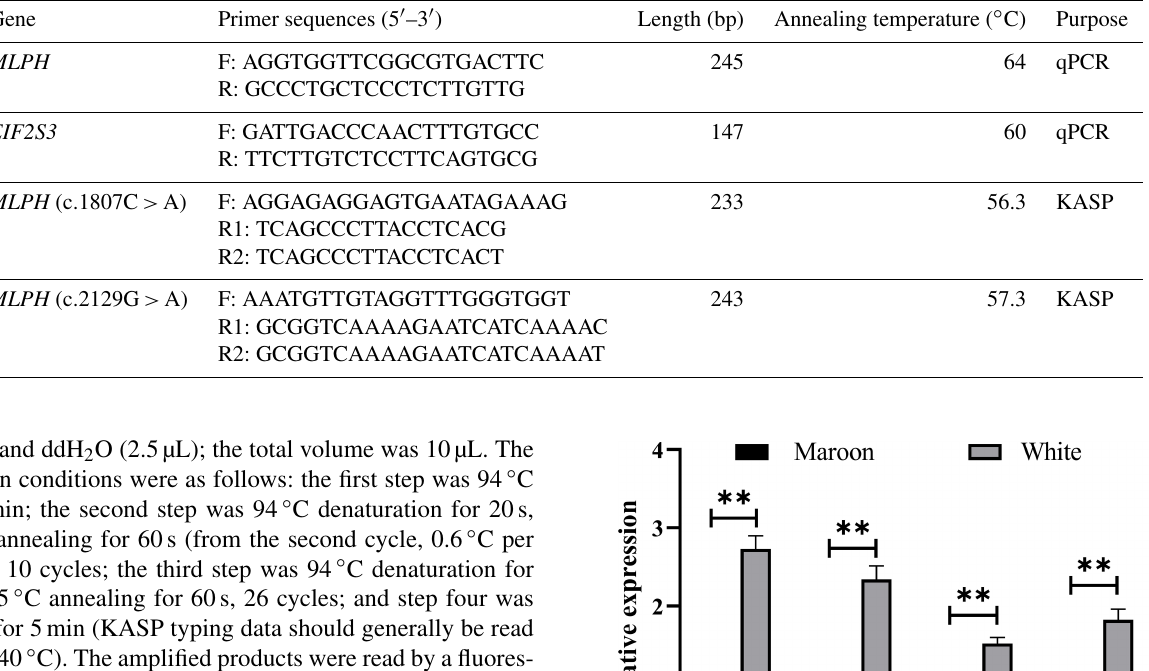
Table 1. The information of KASP and qPCR primers.